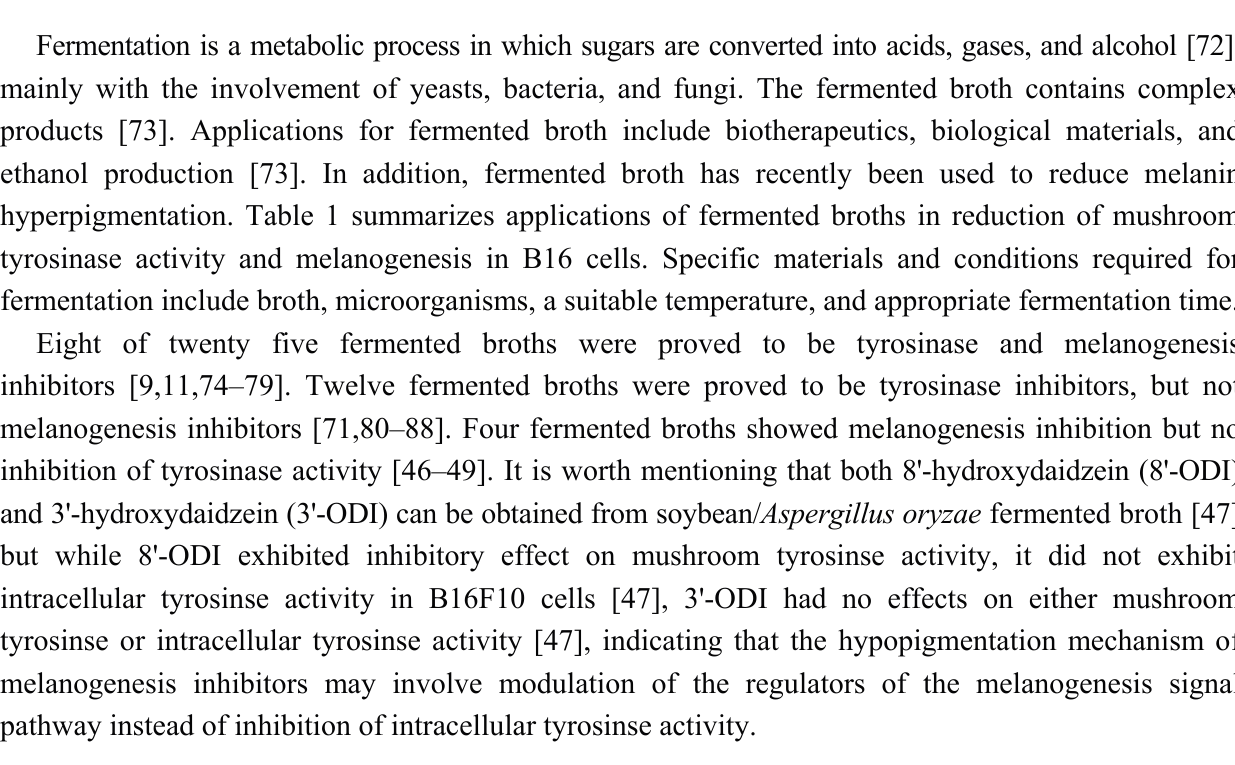
Table 1. Application of the fermented broth in reducing mushroom tyrosinase activity and melanogenesis in B16